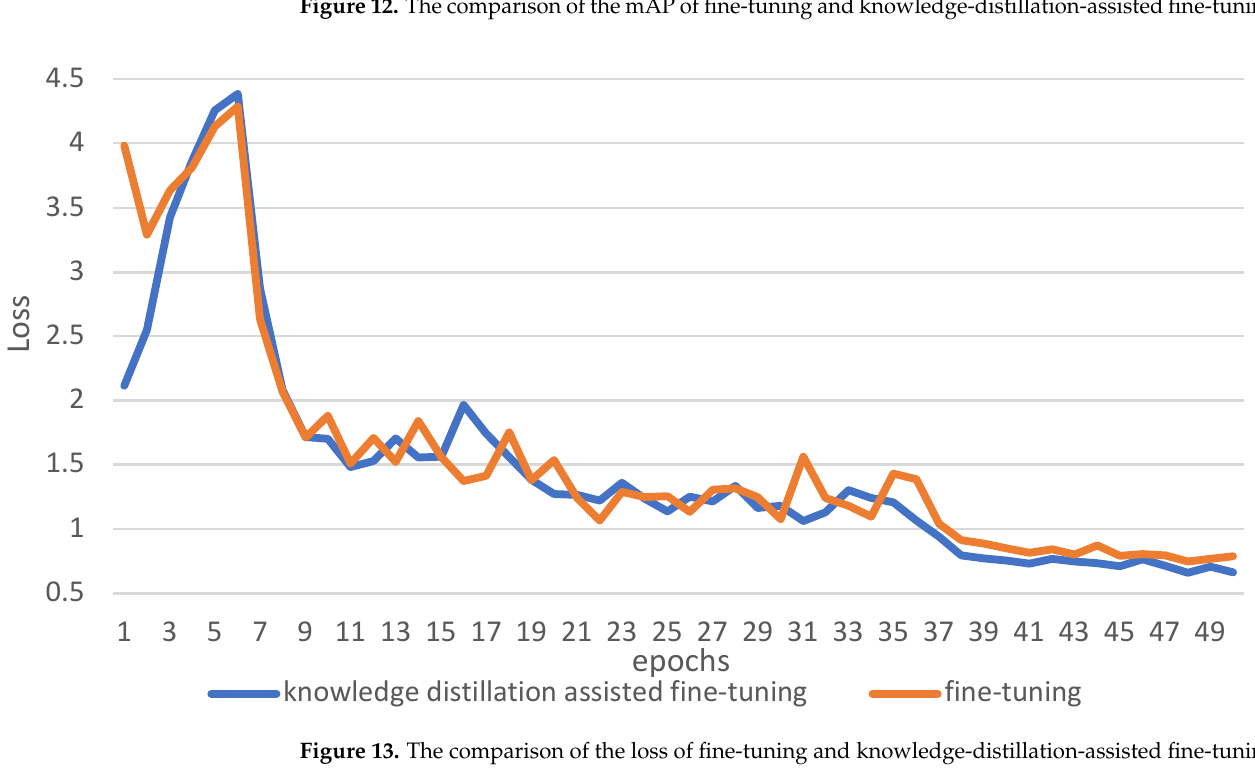
Figure 12. The comparison of the mAP of fine-tuning and knowledge-distillation-assisted fine-tuning.